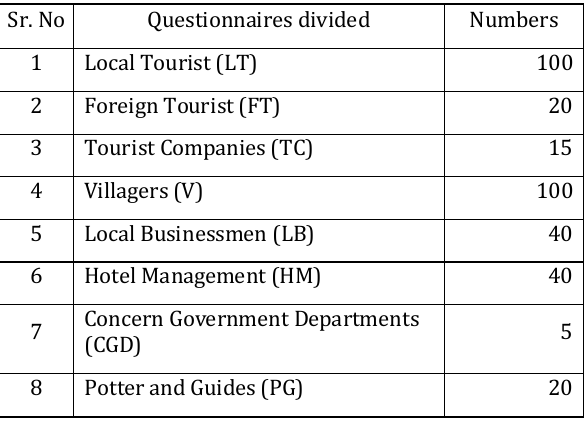
Table 5. Distribution of number of questionnaires